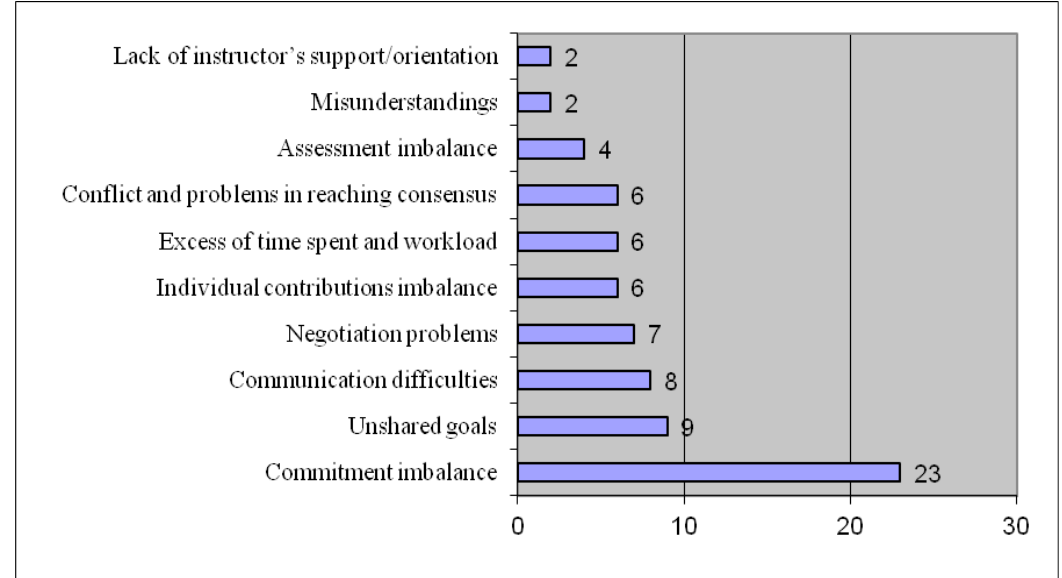
Figure 1 . Students’ sources of frustration in online